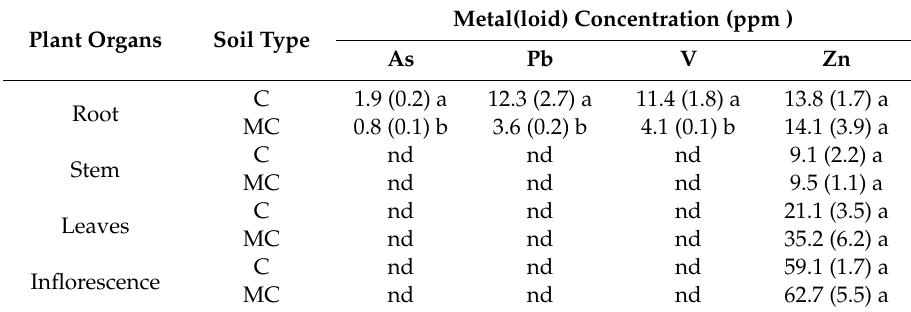
Table 5. Metal(loid) content in the organs of hemp plants ( Cannabis sativa L., cv. Codimono) after 90 days of growth in a greenhouse in pots filled with soil sampled in two di ff erent sites (C and MC) in the “Valle del Sacco” area (Lazio Region, Central Italy). In each column, mean values (n = 4 ± SE)